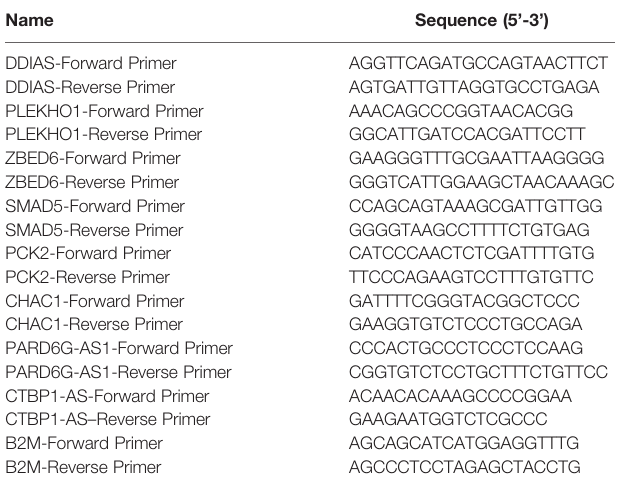
TABLE 1 | The primers for